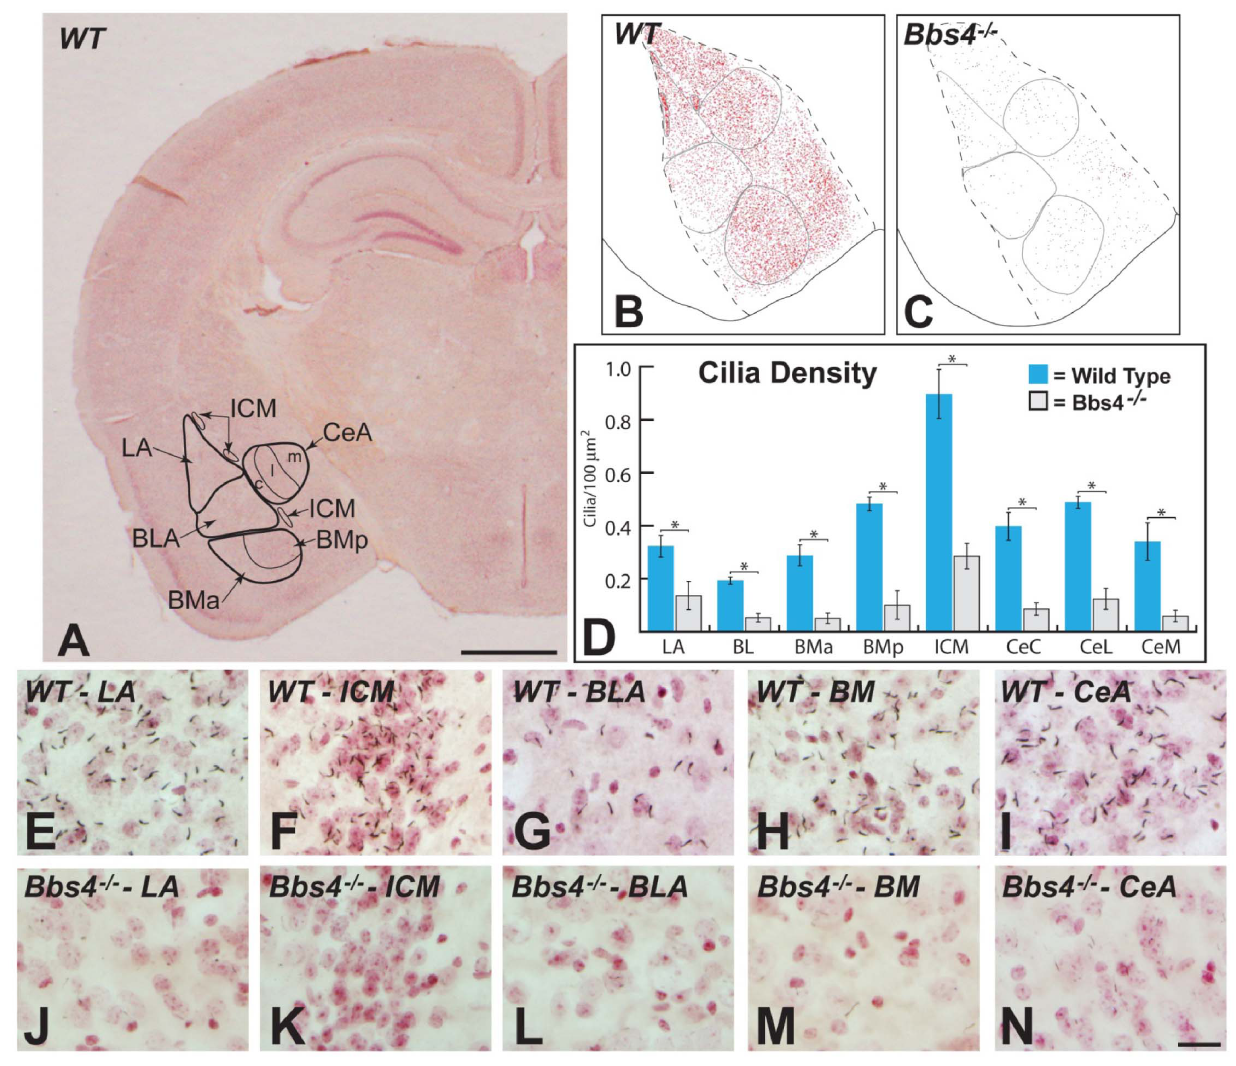
Figure 1. The areas of the amygdala sampled and the distributions of ACIII immunopositive cilia in subdivisions of amygdala in WT and Bbs4 -/- mice are illustrated. Figure A shows the subdivisions of amygdala and the coronal plane that was analyzed in this study. Figures B and C are maps documenting distribution of cilia within these regions of WT (B) and Bbs4 -/- (C) brains that were acquired at high magnification using Sterioinvestigator image analysis software. Figure D shows the density of cilia 6 the SEM within each amygdala subdivision of WT (blue) and Bbs4 -/- (gray) animals; asterisks and brackets indicate where statistical analysis demonstrated statistical differences between WT and Bbs4 -/- mice. The data for (D) was collected from three WT and five Bbs4 -/- mice. High magnification comparisons of the distribution of cilia within comparable regions of each of the amygdala subdivisions are demonstrated in figures E through N. Note the association of cilia with neurons counterstained with neutral red in each region as well as the dramatic reduction in ACIII + cilia in Bbs4 -/- animals. BLA = basolateral nucleus of amygdala; BMa = basomedial amygdala, anterior part; BMp = basomedial amygdala, posterior part; CeA = central nucleus of amygdala with capsular (c), lateral (l) and medial (m) subdivisions; ICM = intercalated cell masses; LA = lateral nucleus of amygdala. Scale bar in figure A = 1 mm, in N = 20 m m; figures E – N are of the same magnification.